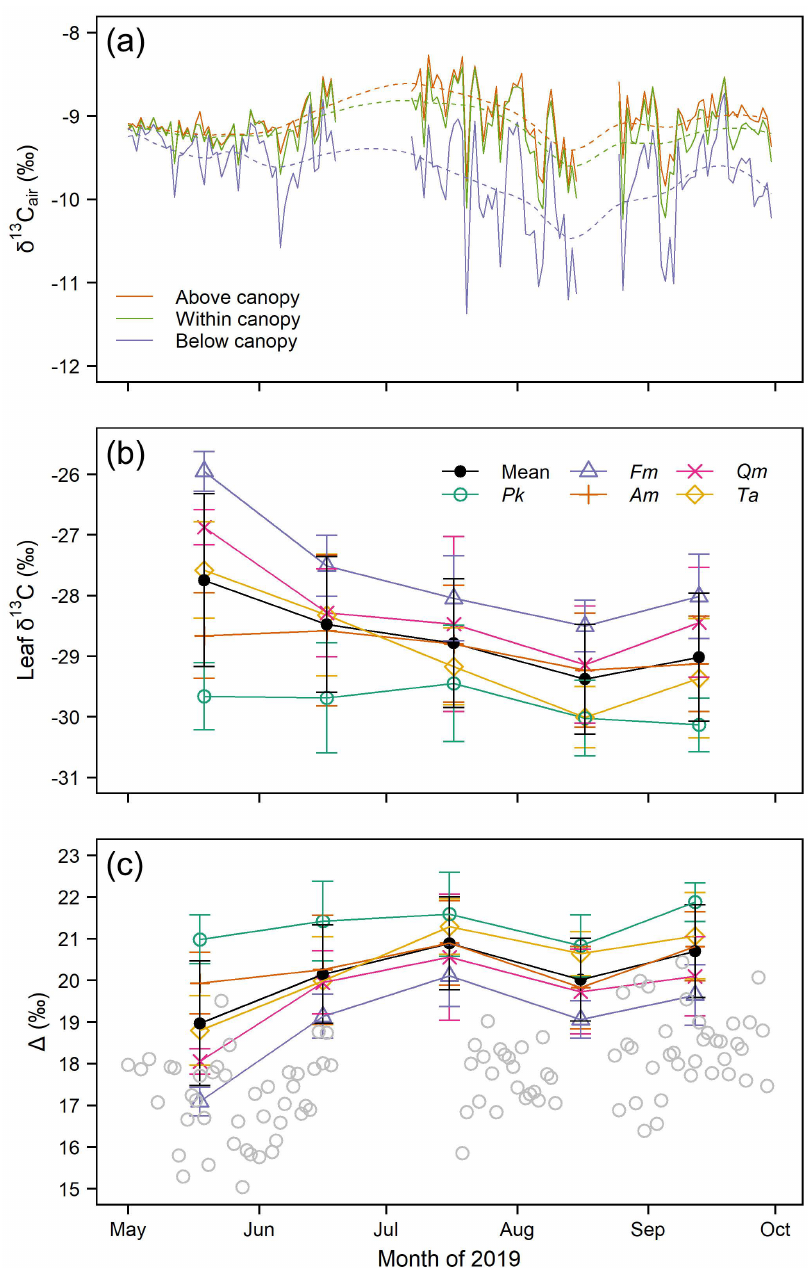
Figure 3. Seasonal variation in the δ 13 C of atmospheric CO 2 ( δ 13 C air ) ( a ), seasonal variation in the δ 13 C of leaf bulk organic matter ( b ), and C isotope discrimination at the leaf and canopy levels ( c ) during the growing season of 2019. δ 13 C air values are given as daily averages. The δ 13 C air values below the canopy were averaged from data collected at heights of 2.5 and 8 m; the δ 13 C air values within the canopy were averaged by data collected at heights of 22, 26, and 32 m; the δ 13 C air values above the canopy were averaged by data collected at heights of 50 and 60 m. The dashed line is the locally weighted scatterplot smoothing (LOESS) with span = 0.3. The two periods of missing data in June and August were caused by power failure. Leaf δ 13 C values (mean ± SE, n = 9) were aggregated from three canopy heights (lower, middle, and upper). ∆ leaf was calculated from leaf δ 13 C and δ 13 C air and separated by species; gray circles represent ∆ canopy derived from Farqhar’s ∆ classical model. Pk , Korean pine ( P. koraiensis ); Fm , Manchurian ash ( F. mandshurica ); Am , Mono maple ( A. mono ); Qm , Mongolian oak ( Q. mongolica ); Ta , Tuan linden ( T. amurensis ). Error bars indicate standard